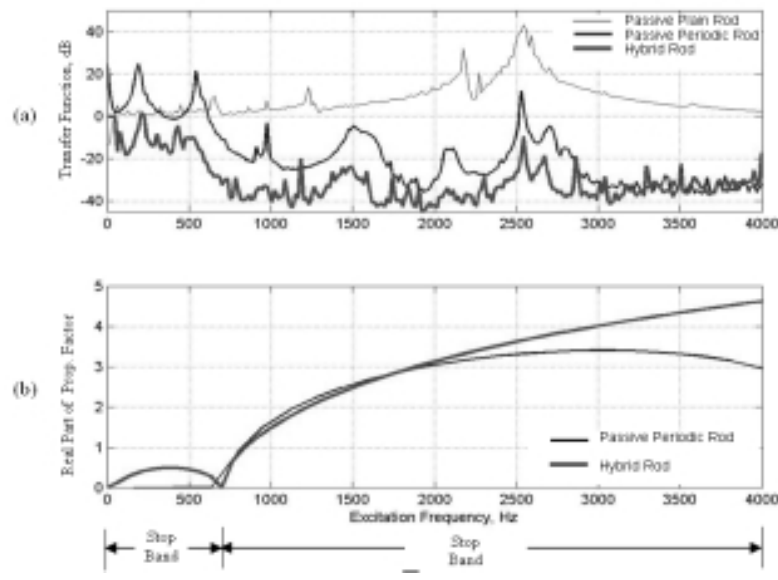
Fig. 10. The transfer functions of the plain, passive periodic, and hybrid periodic rods with the propagation factor in both passive and active modes. periodicity and open circuit), and third, for the hybrid periodic rod (i.e. with periodicity and short circuit). The phase shifter has been used to introduce a feedback signal to the actuator to produce the destructive interference of